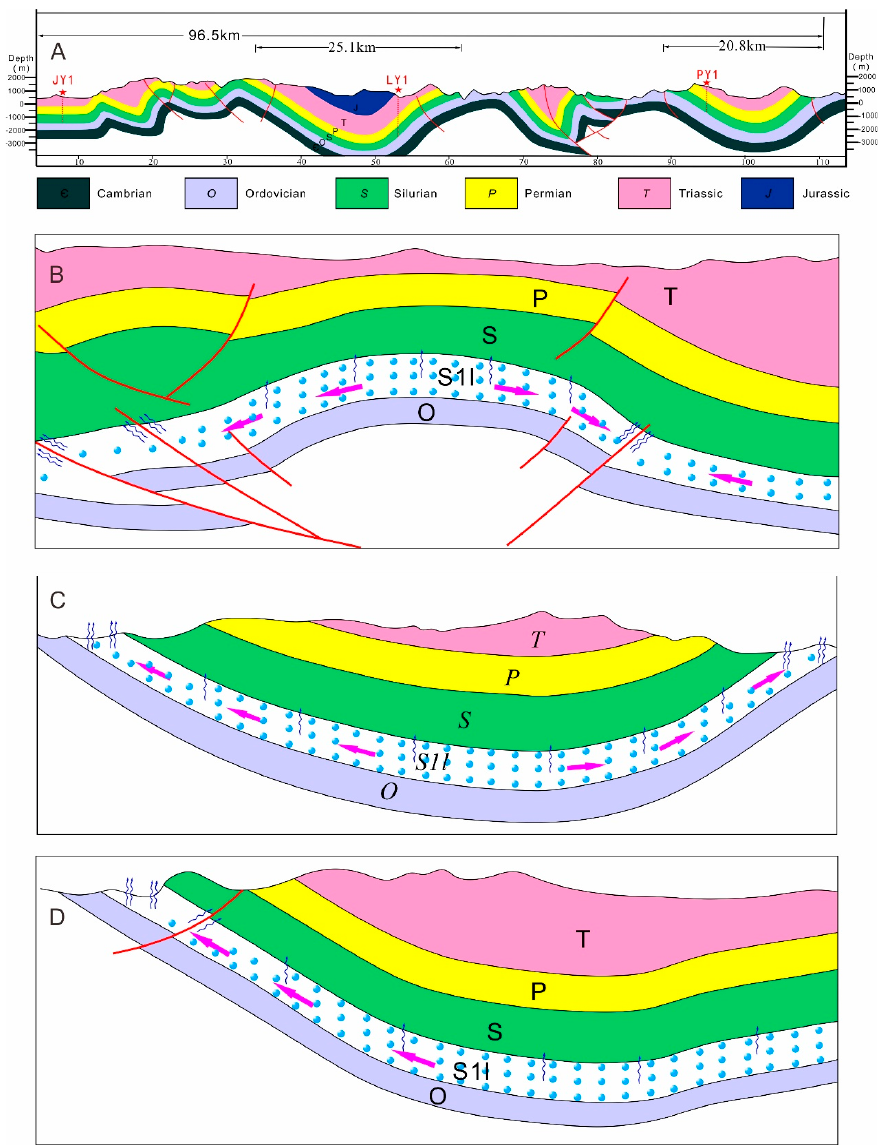
Figure 13. Structural preservation styles of shale gas in southeast Chongqing. ( A ): Geological struc- ture section of southeast Chongqing. ( B ): Reservoir forming model of anticline in basin. ( C ): Reservoir forming model of residual syncline outside the basin. ( D ): Reservoir forming model of residual slope outside the basin.